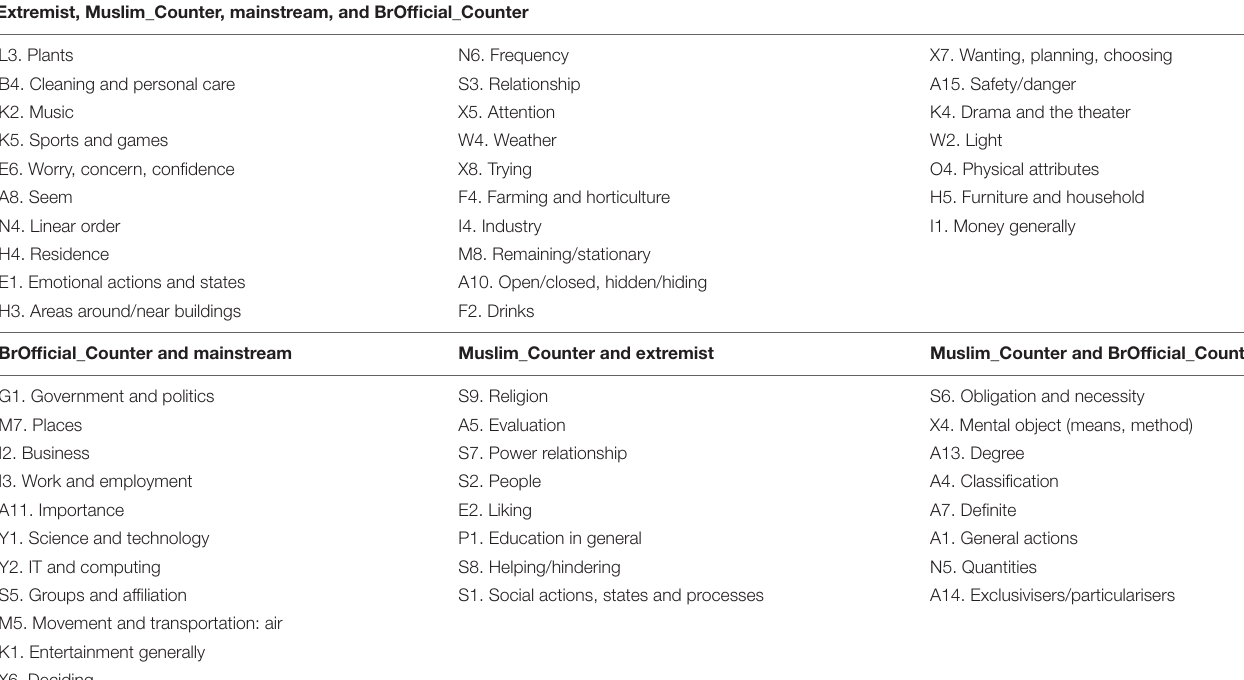
TABLE 6 | Listing shared conceptual categories between selected groups of message